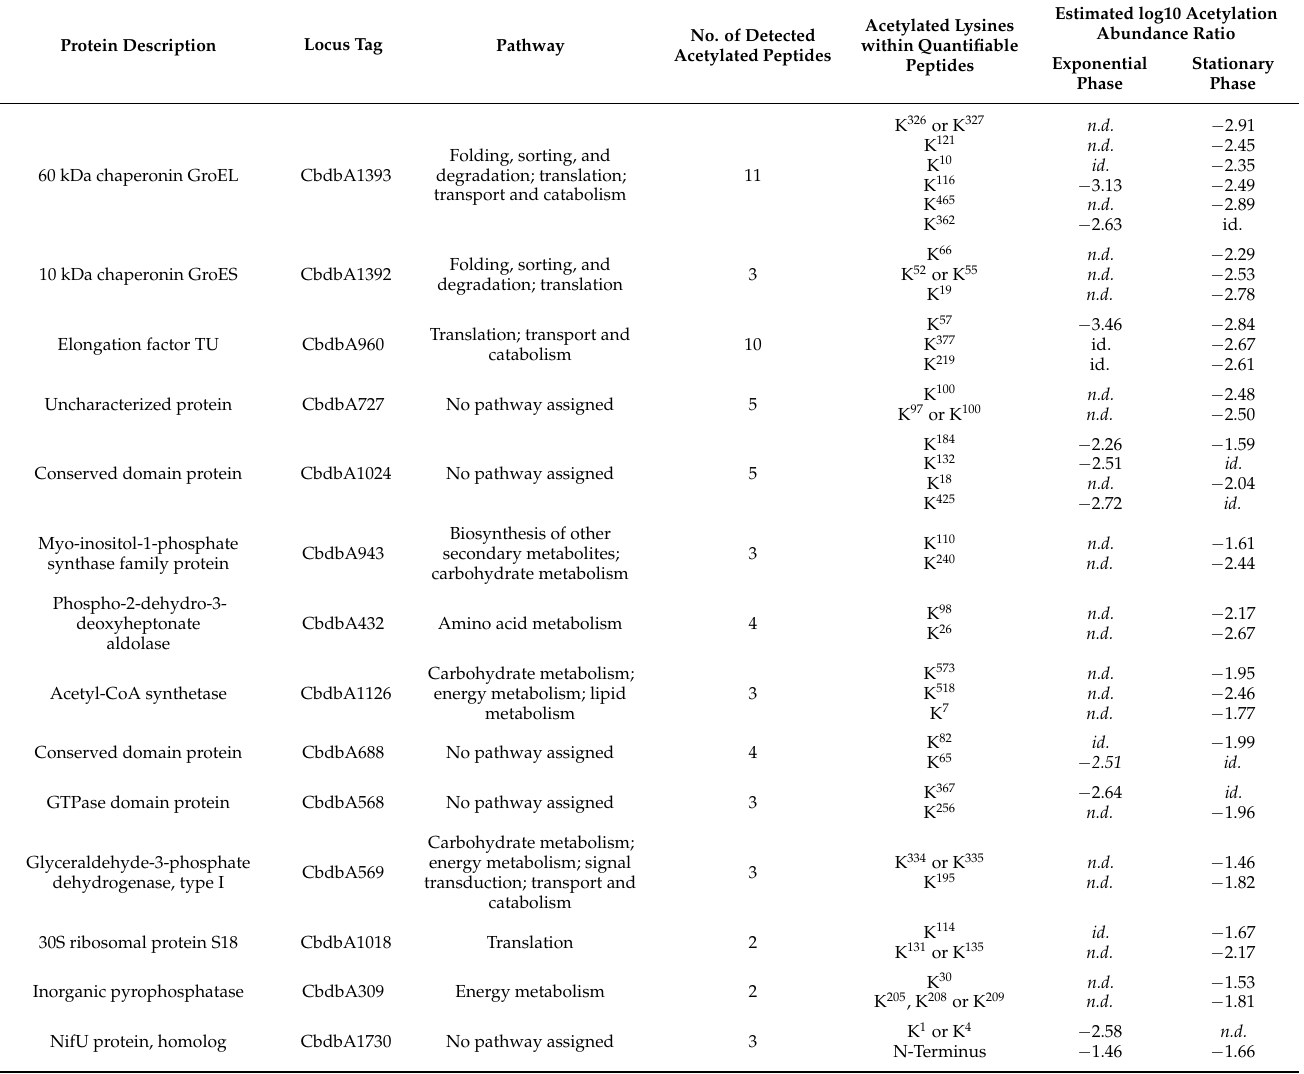
Table 2. Proteins with multiple quantifiable acetylation